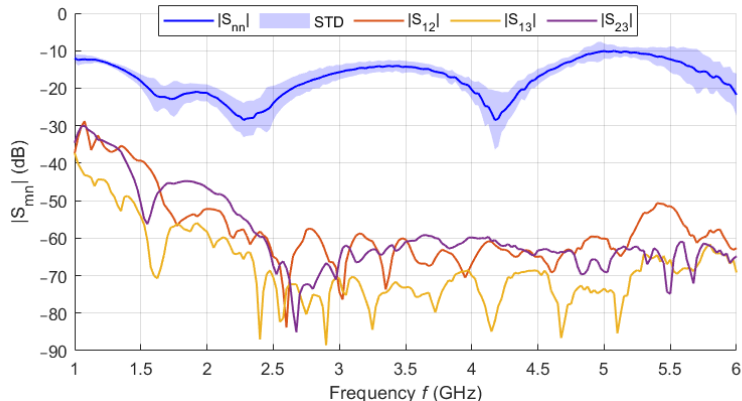
Figure 21. Results of 2D reconstruction for catheter position 1, 2, and 3: ( a ) Homogeneous numerical model; ( b ) Experimental model measurement.